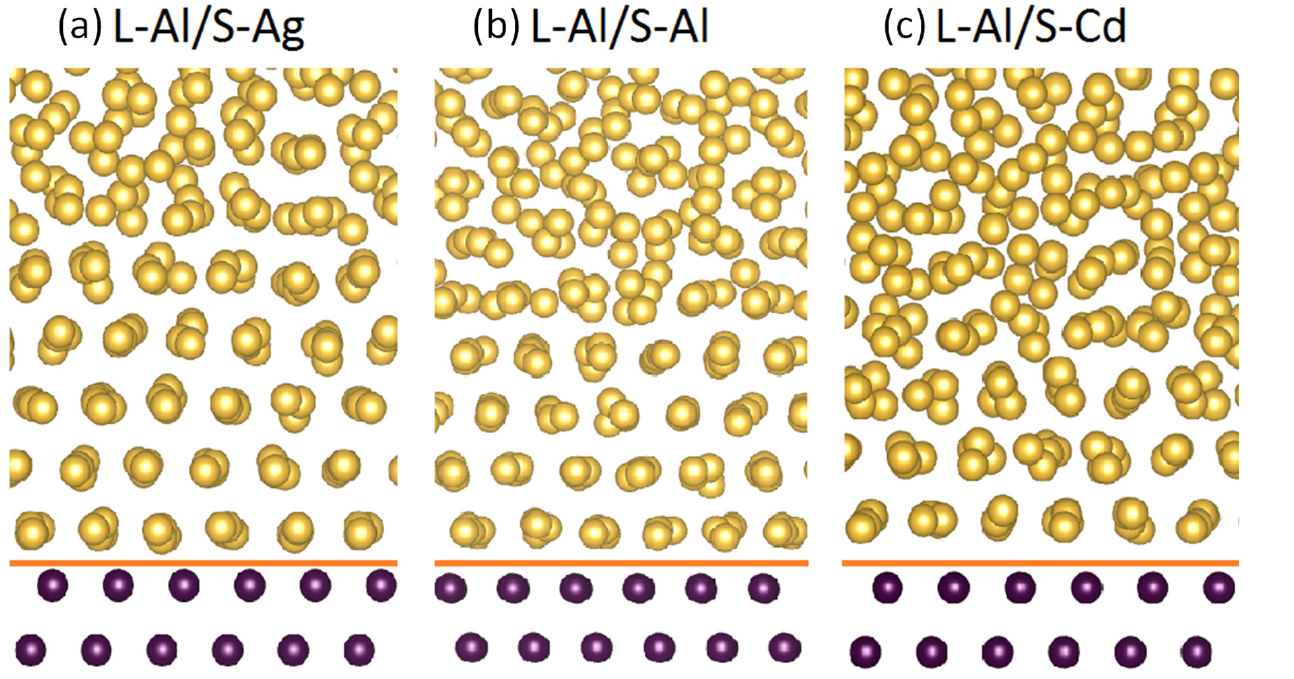
Figure 13. Chemistry effect on prenucleation at the liquid/substrate interface [26]. Snapshots of the simulation systems of the liquid Al and pinned substrate: ( a ) L-Al/S-Ag, ( b ) L-Al/S-Al, and ( c ) L-Al/S-Cd systems. All systems were equilibrated at 1000 K. The violet and light gold spheres represent the substrate and liquid atoms, respectively, and the solid orange lines mark the Gibbs dividing interface between the substrate and the liquid.